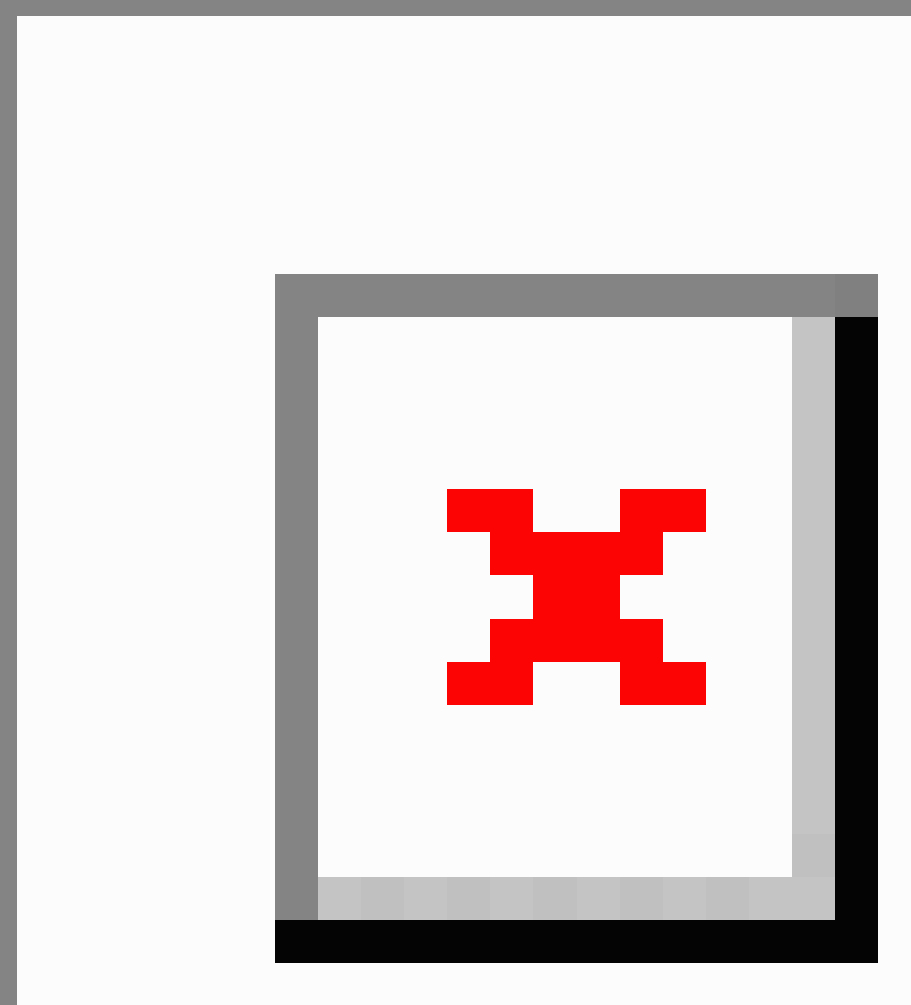
Figure 2. Photoplethysmography (PPG) principle by